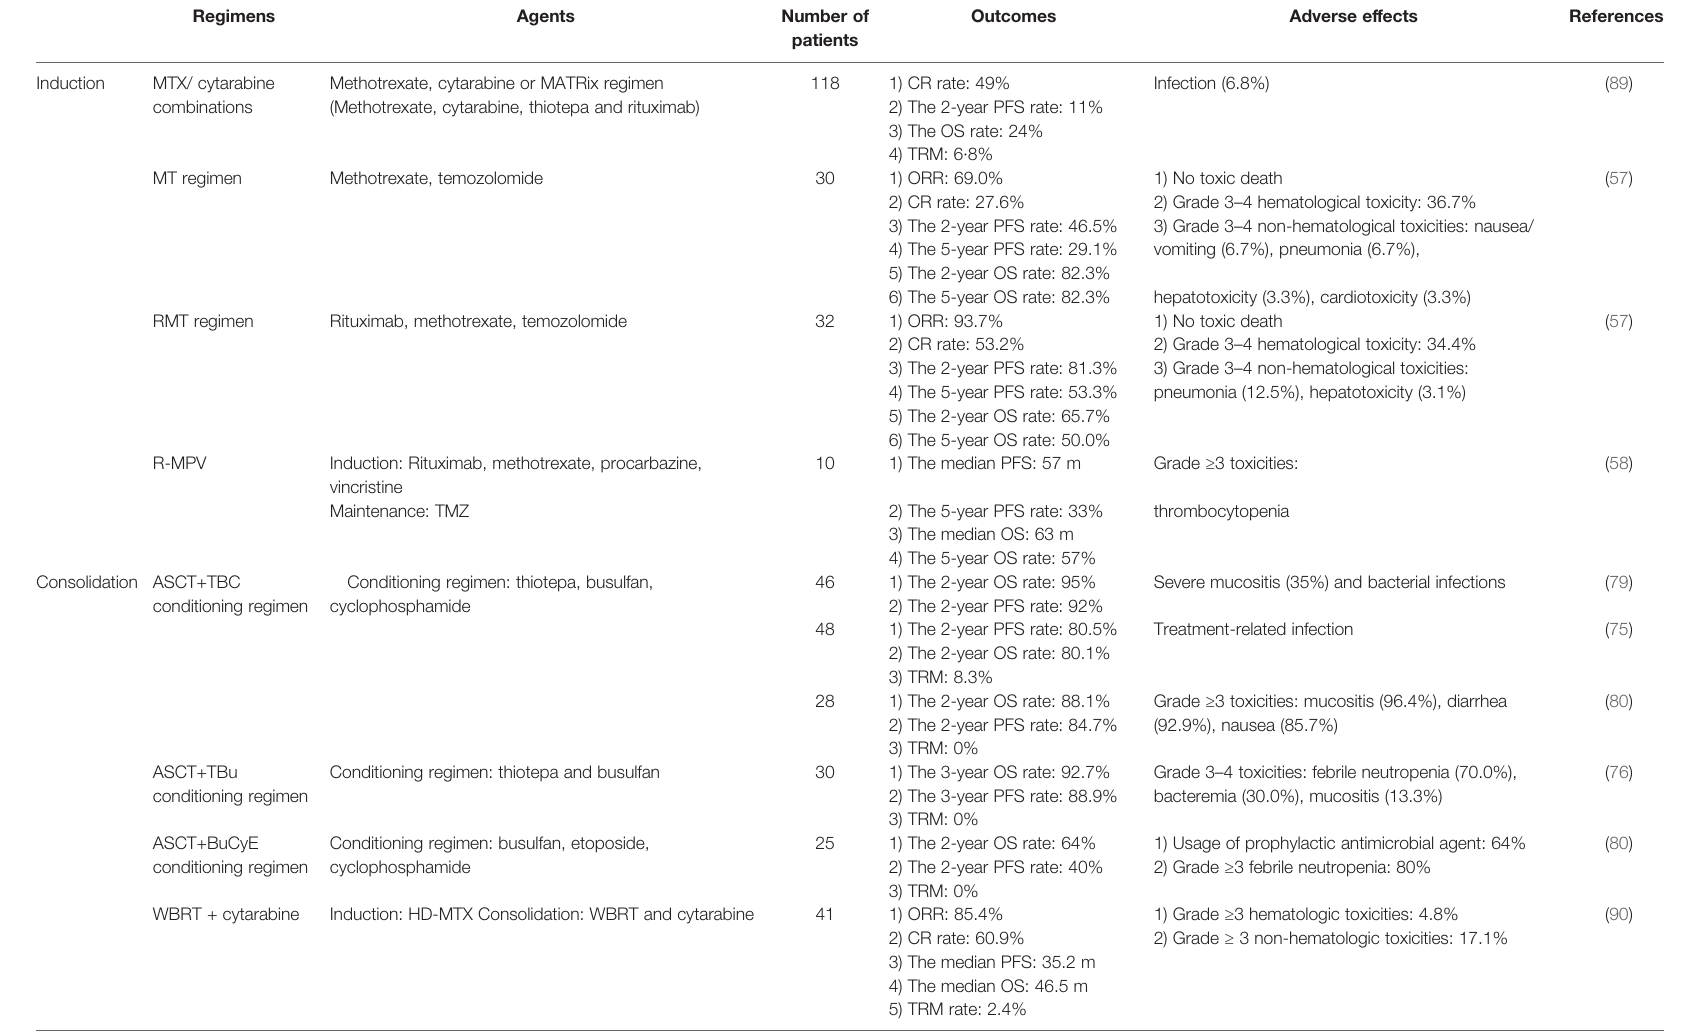
TABLE 2 | Recent treatment options for